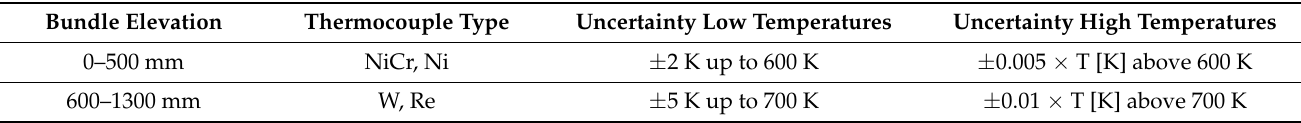
Figure 2. Heated rod geometry, axial view [5]. Table 2. Thermocouples’ uncertainties